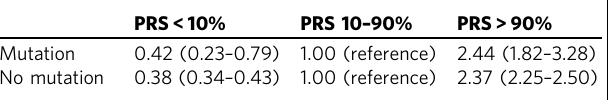
Table 5 To test for interaction in all 122,978 women, we compared the polygenic risk score (PRS) effect size in pooled mutation carriers (pooling PALB2 and CHEK2 ) and in non-carriers.